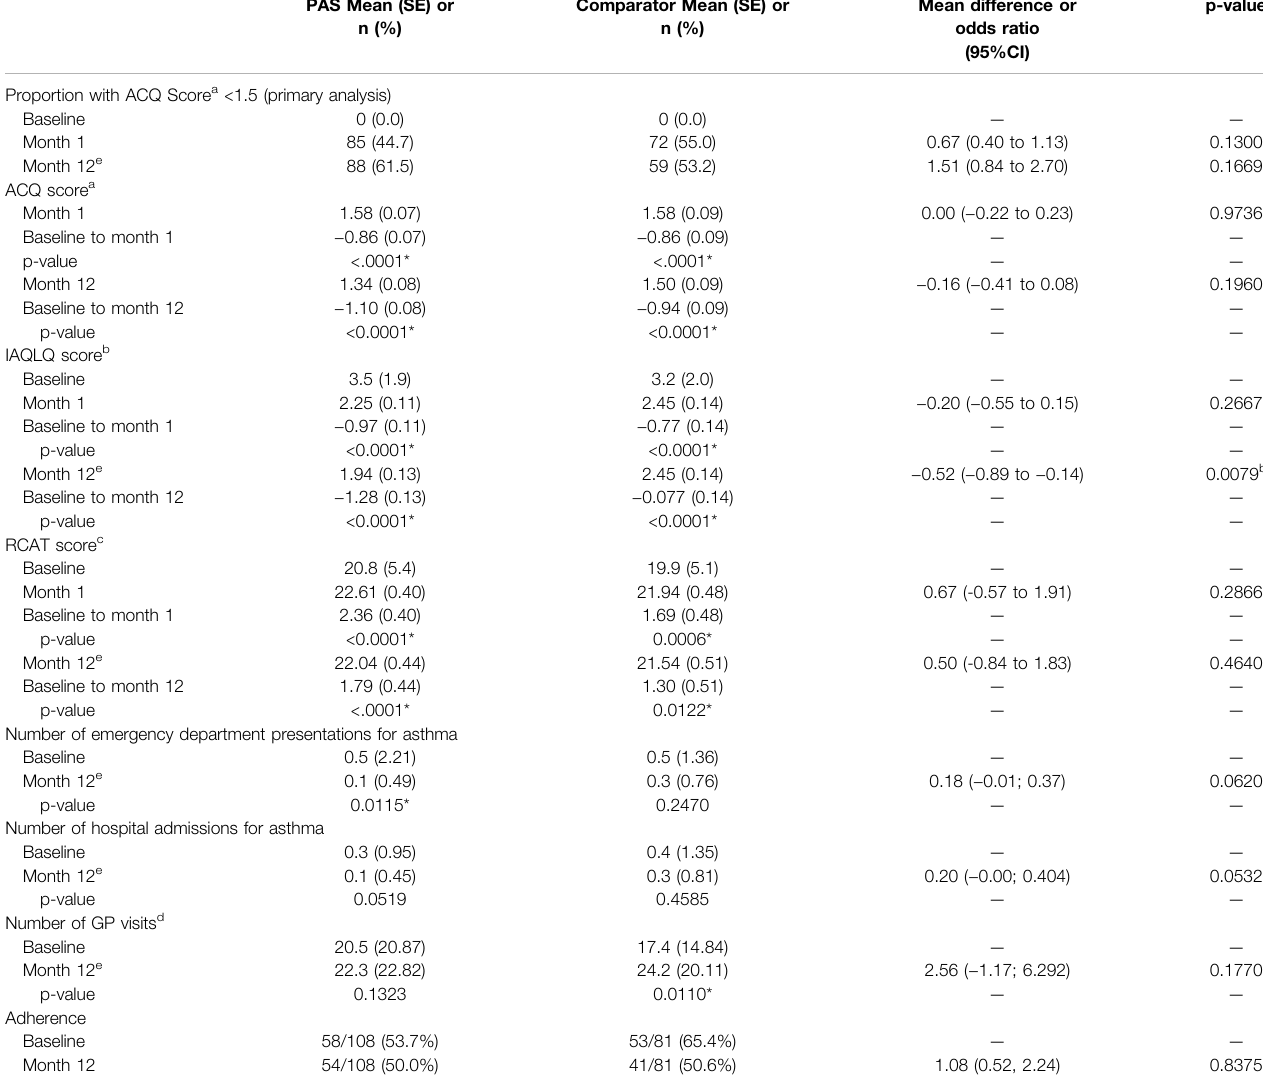
TABLE 2 | Primary and secondary outcomes.